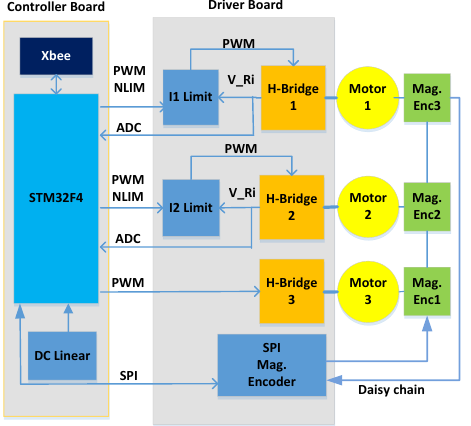
Figure 9. The schematics of the mechatronics system of the UC-Softhand is composed of drivers for gear motors with current measurement and current limiter, a Daisy chain of magnetic encoders and an ARM Cortex-M4 STM32